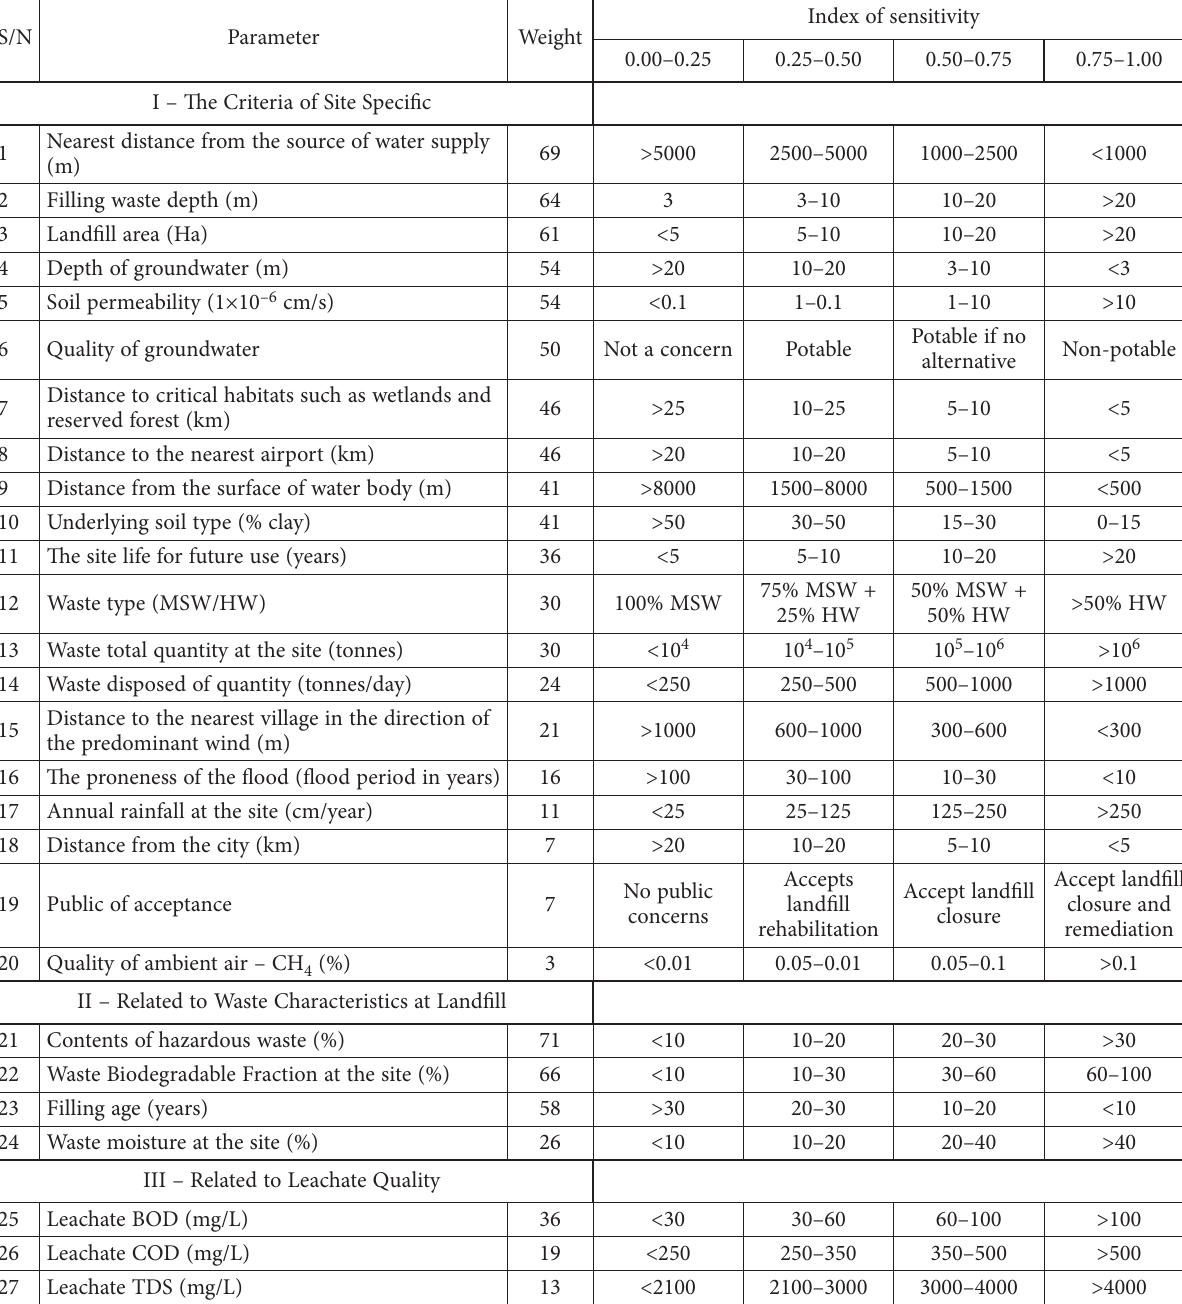
Table 1. The IRBA decision-making parameters (source: Kurian et al.,